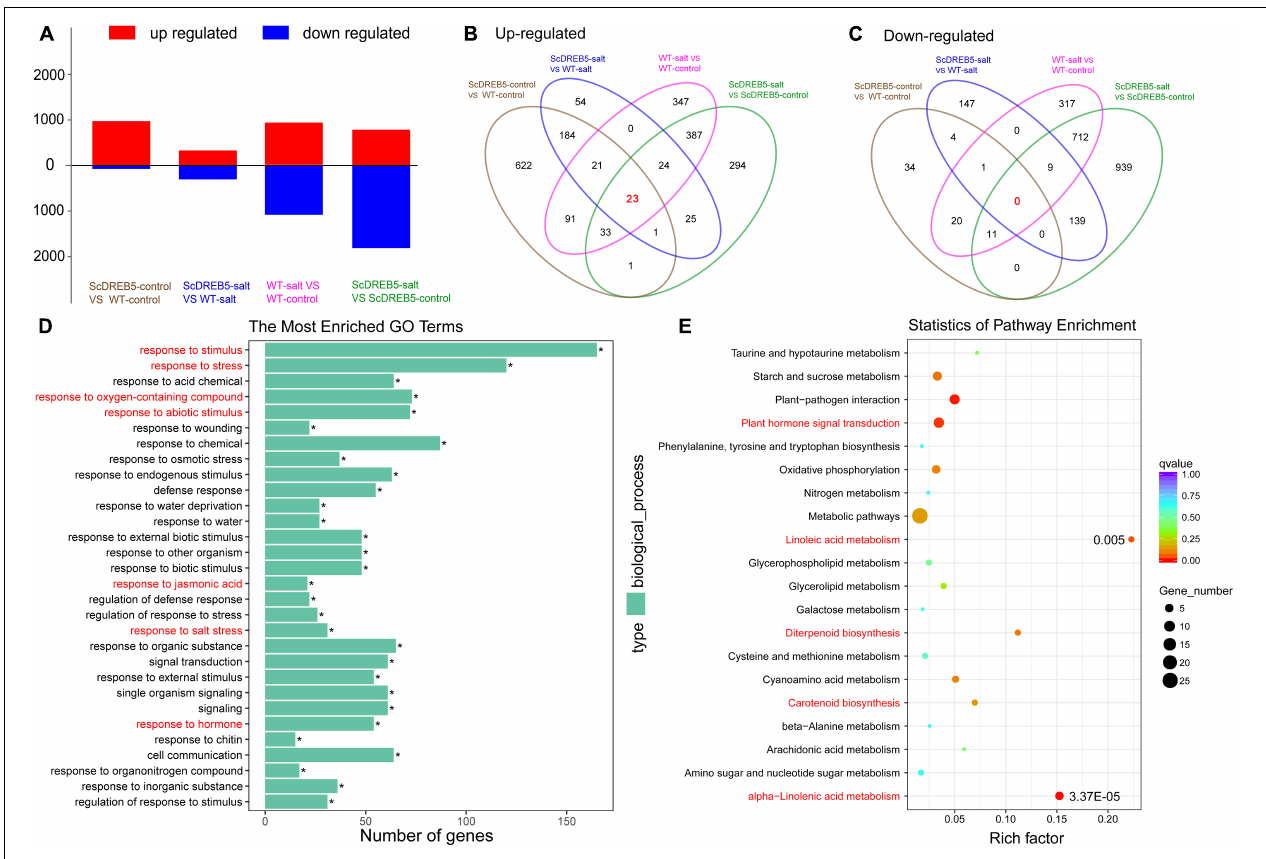
FIGURE 5 | Differentially accumulated transcripts, GO enrichment, and KEGG pathway analysis between ScDREB5 transgenic and WT plants based on RNA-seq analysis. (A) Number of DEGs in WT and the transgenic ScDREB5 plants under normal and salt stress condition. (B,C) Overlapping analyses of up- and downregulated genes induced by ScDREB5 or salt stress. (D,E) GO term and KEGG analyses of the upregulated genes under salt stress ( ScDREB5 -salt vs.